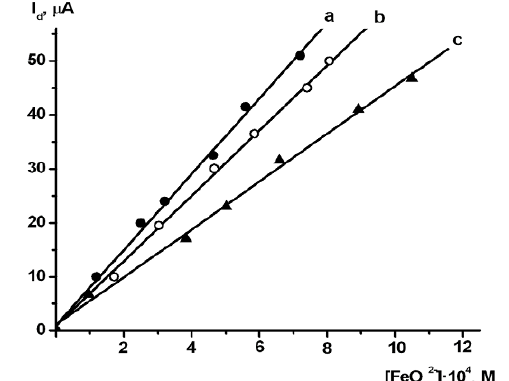
Figure 2. Dependence of diffusion current on the concentration of ferrate(VI) in different strength of NaOH solution at Е = -0.4 V. a – 10.0 М NaOH; b - 12.5 М NaOH; c – 15.0 М NaOH